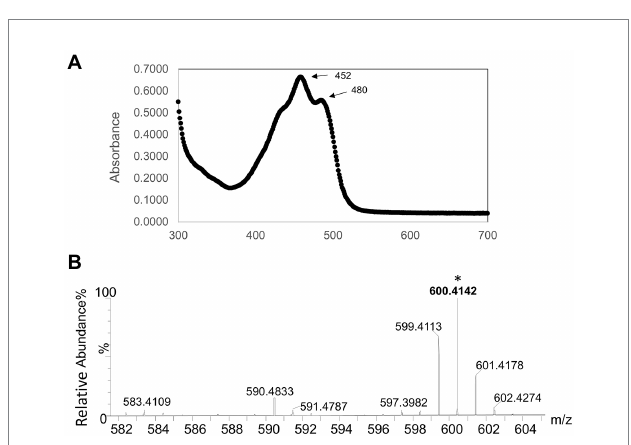
FIGURE 3 Identification of the carotenoid produced by strain AK-PDB1-5 T (A) Ultraviolet-visible absorption spectra (UV–Vis) of the major carotenoid from AK-PDB1-5 T (B) ESI-MS ion spectra of the carotenoids from AK-PDB1-5 T